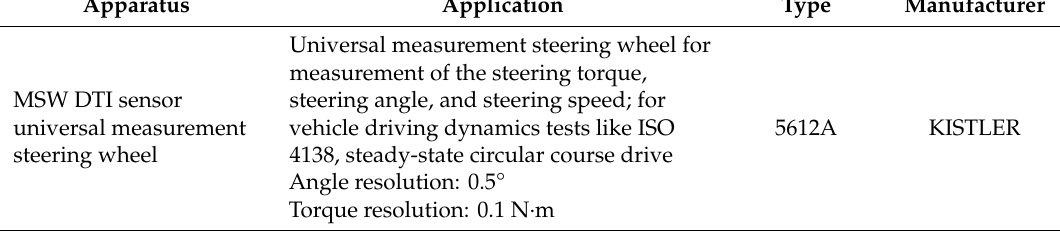
Figure 5. The test vehicle and experimental apparatus: ( a ) MSW DTI sensor universal measurement steering wheel; ( b ) the test vehicle and the installation position of experimental apparatus; ( c ) Correvit S-Motion DTI Non-contact optical sensor. Table 2. Detailed information on the main apparatuses.